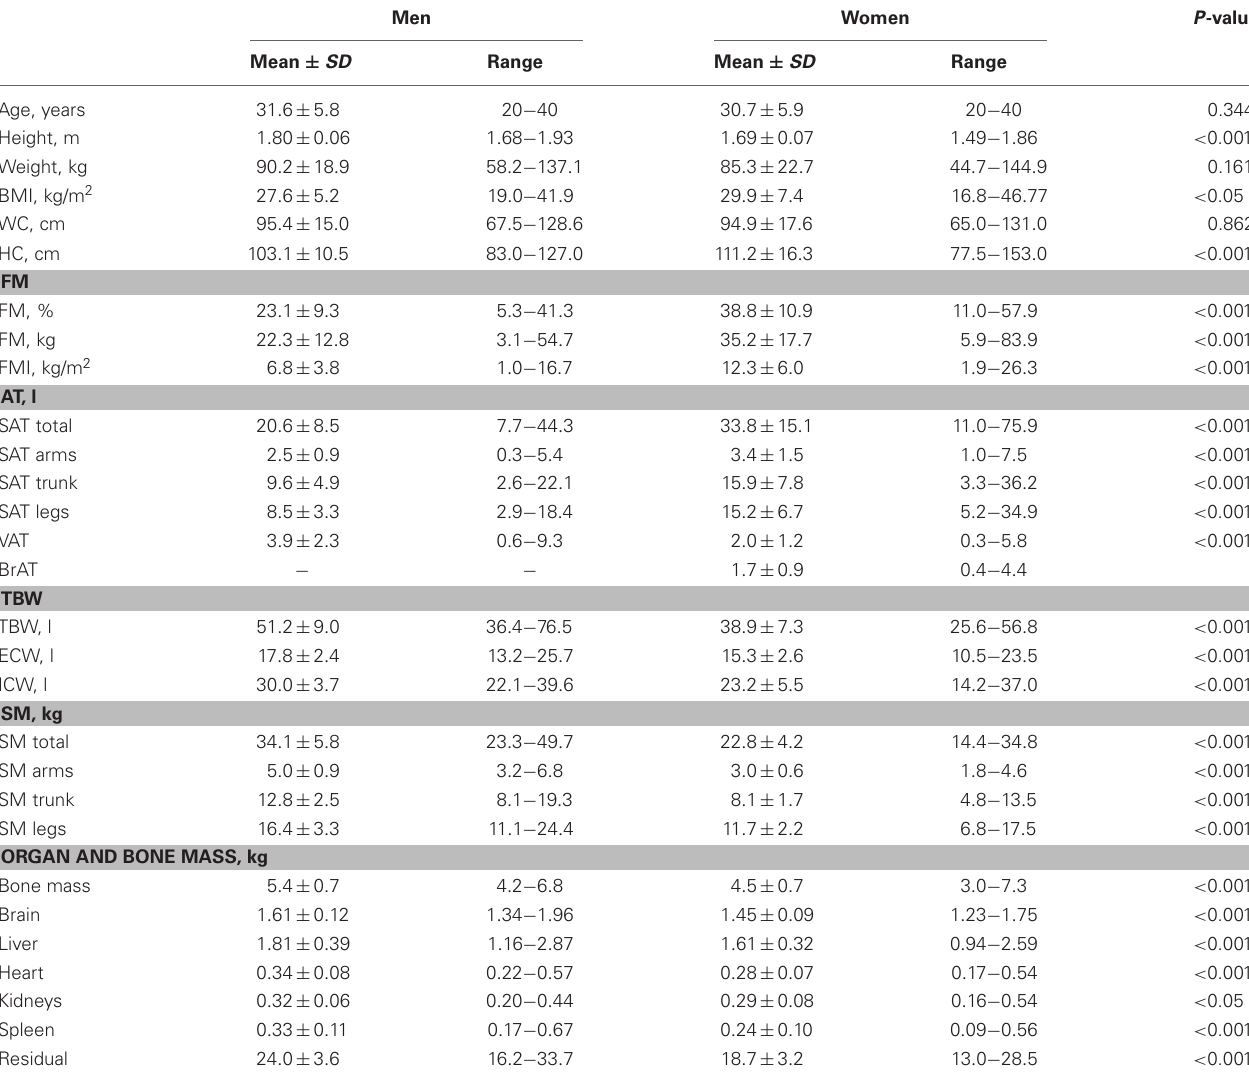
Table 1 | Detailed body composition in a healthy adult reference population ∗ .